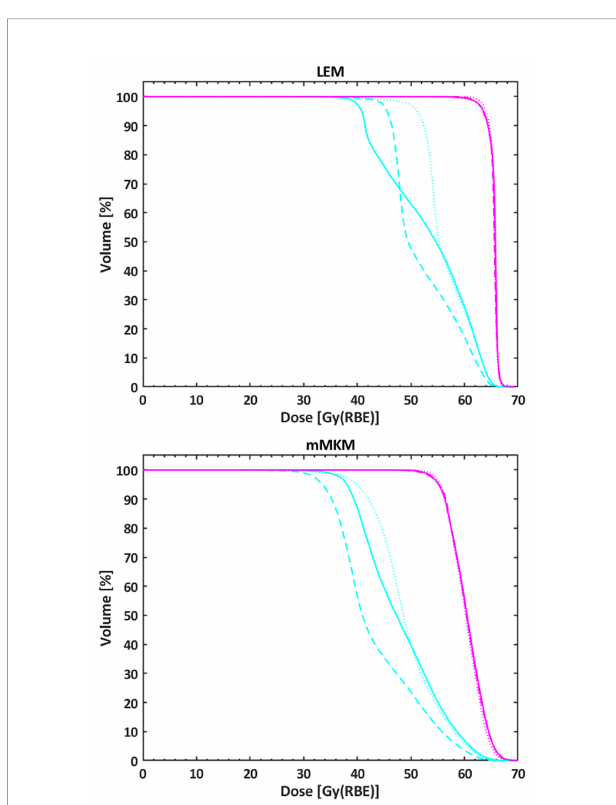
FIGURE 2 | DVHs of the HR-CTV (purple line) and the LR-CTV (light blue line) of P6 achieved with the SEQ (solid line), the SIB 54.4 (dotted line), and the SIB 48.0 (dashed line) approaches. The top (bottom) panel corresponds to LEM (mMKM) doses. DVH, dose – volume histogram; HR-CTV, high-risk clinical target volume; LR-CTV, low-risk clinical target volume; SEQ, sequential boost; SIB, simultaneous integrated boost; LEM, local effect model; mMKM, modi fi ed microdosimetric kinetic